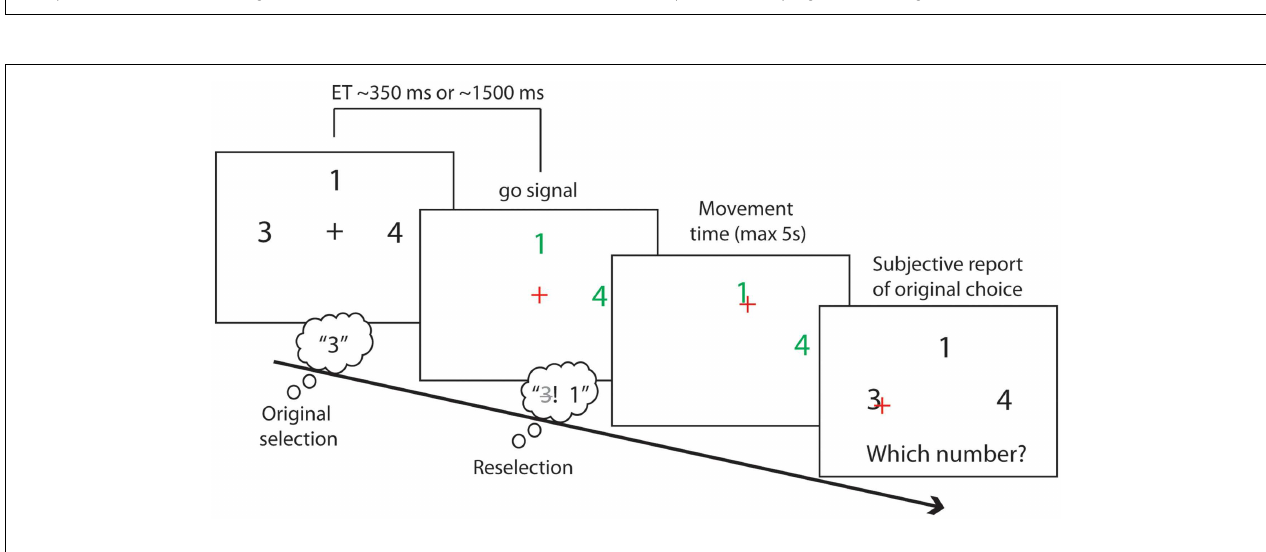
scenarios are thus possible.The internal response set may be flexible (Null hypothesis: H 0 ), and can update its contents to respond rapidly to external changes. Alternatively (Experimental hypothesis: H 1 ), the internal response set may be resilient to change, and the internal response set may lag behind changes in the external environment.